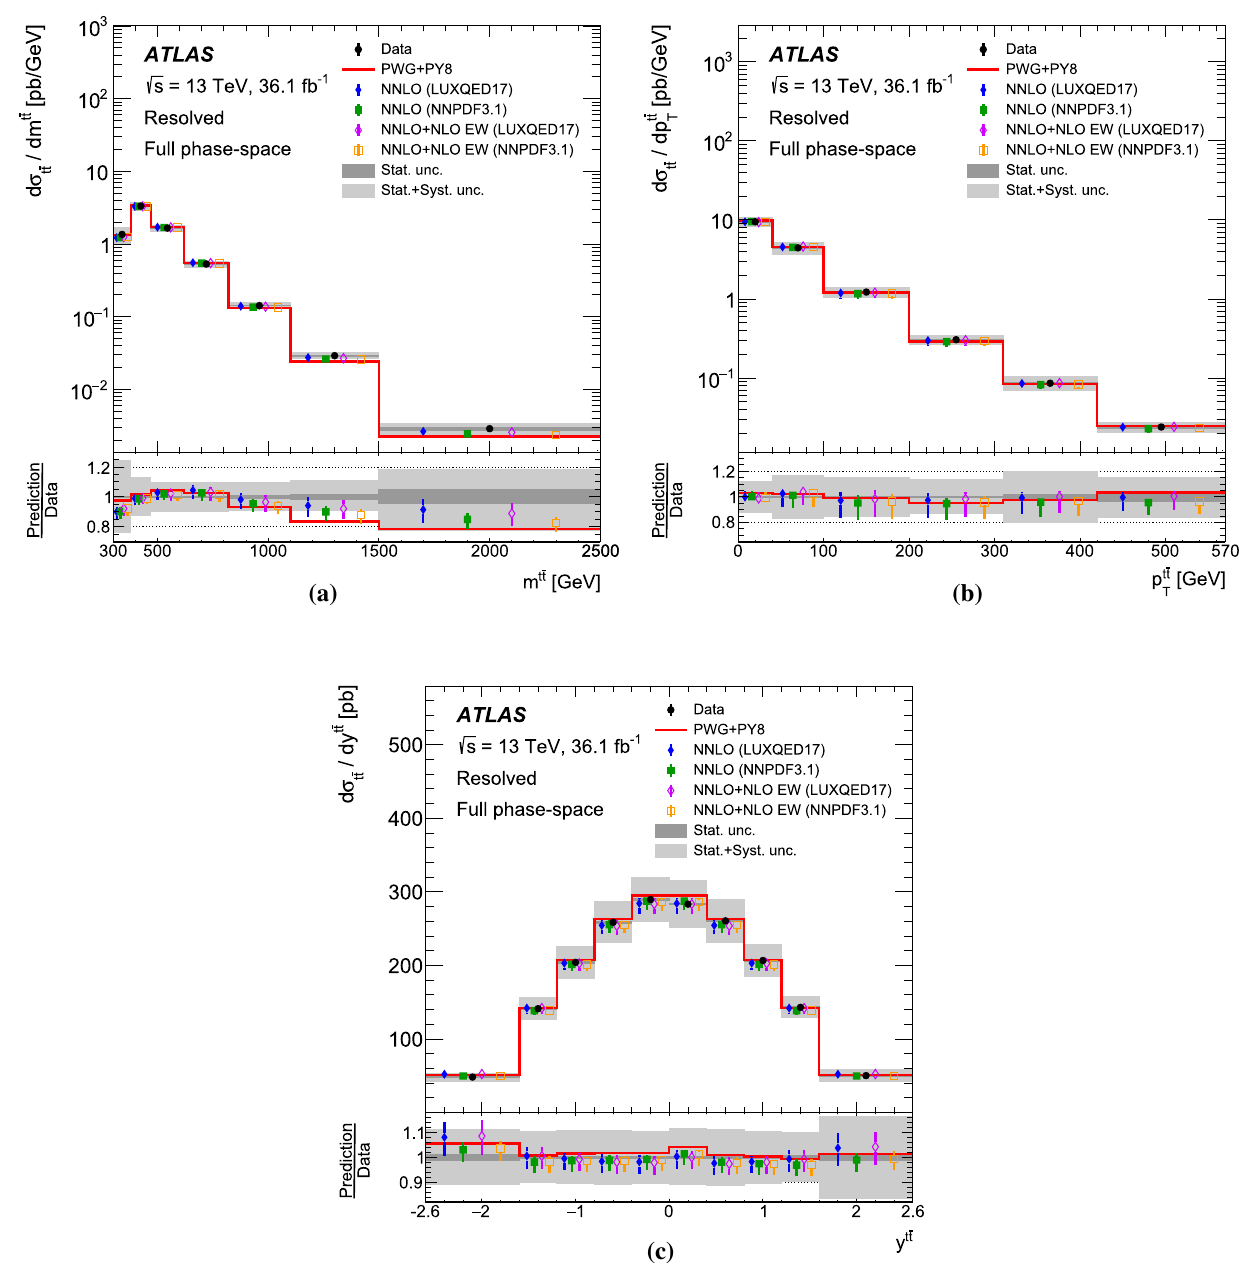
Fig. 65 Parton-level absolute differential cross-sections as a function of a m t ¯ t , b p t ¯ t and c y t ¯ t in the resolved topology. The results are com- T paredwithNNLOQCDandNNLOQCD+NLOEWtheoreticalcalcula- tions using the NNPDF3.1 and LUXQED17 PDF sets. The vertical bars on each marker represents the total uncertainty in the prediction. The